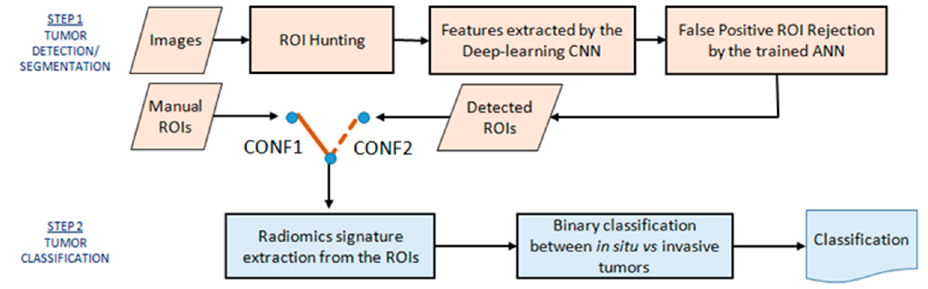
Figure 1. A flowchart of the software. CONF1 and CONF2 denote the two configurations in which the tumor classification (Step 2) was tested, i.e., respectively with manual ROIs as input, or fed up with the automatically detected ROIs (coming from Step 1).